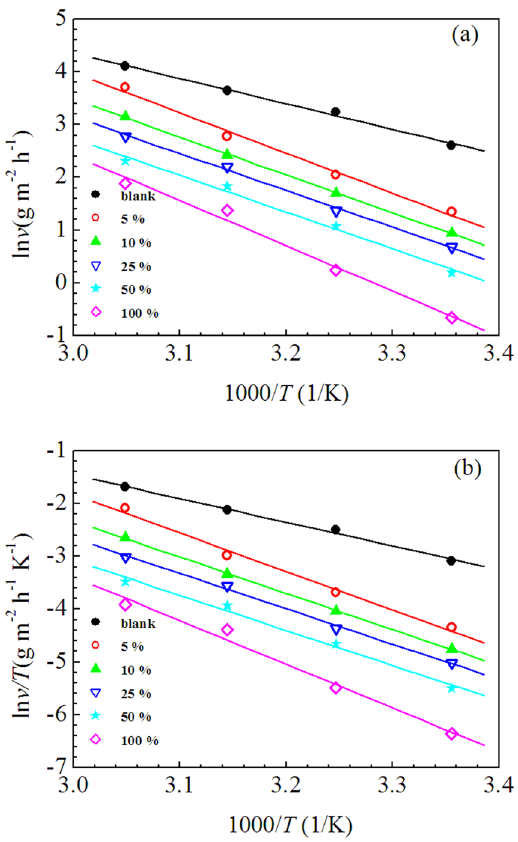
Figure 7. Arrhenius plots ( a ) and Transition state plots ( b ) for mild steel in 0.5 M H 2 SO 4 solution in the absence and presence of various V/V concentrations of